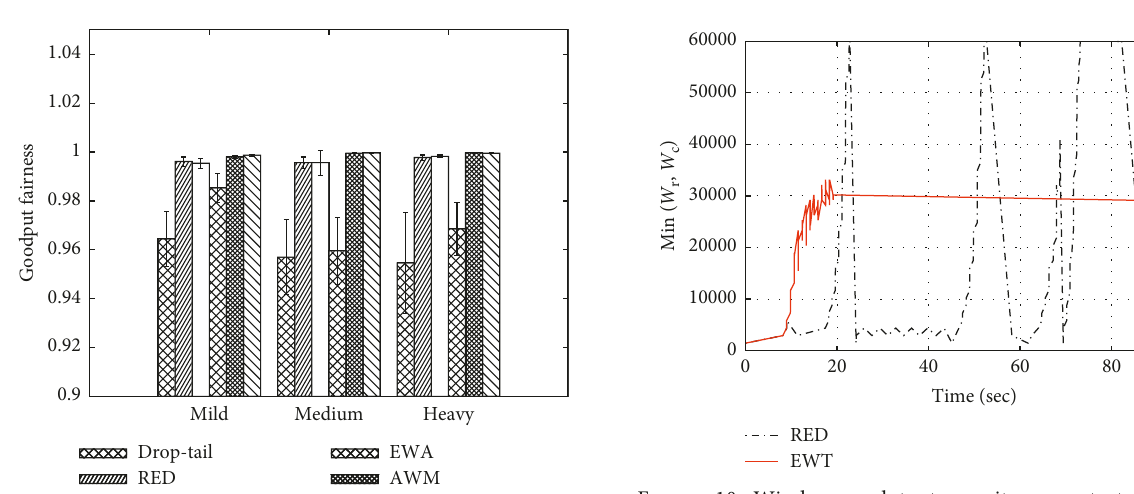
Figure 10: Window used to transmit segments to a flow in Scenario 1.